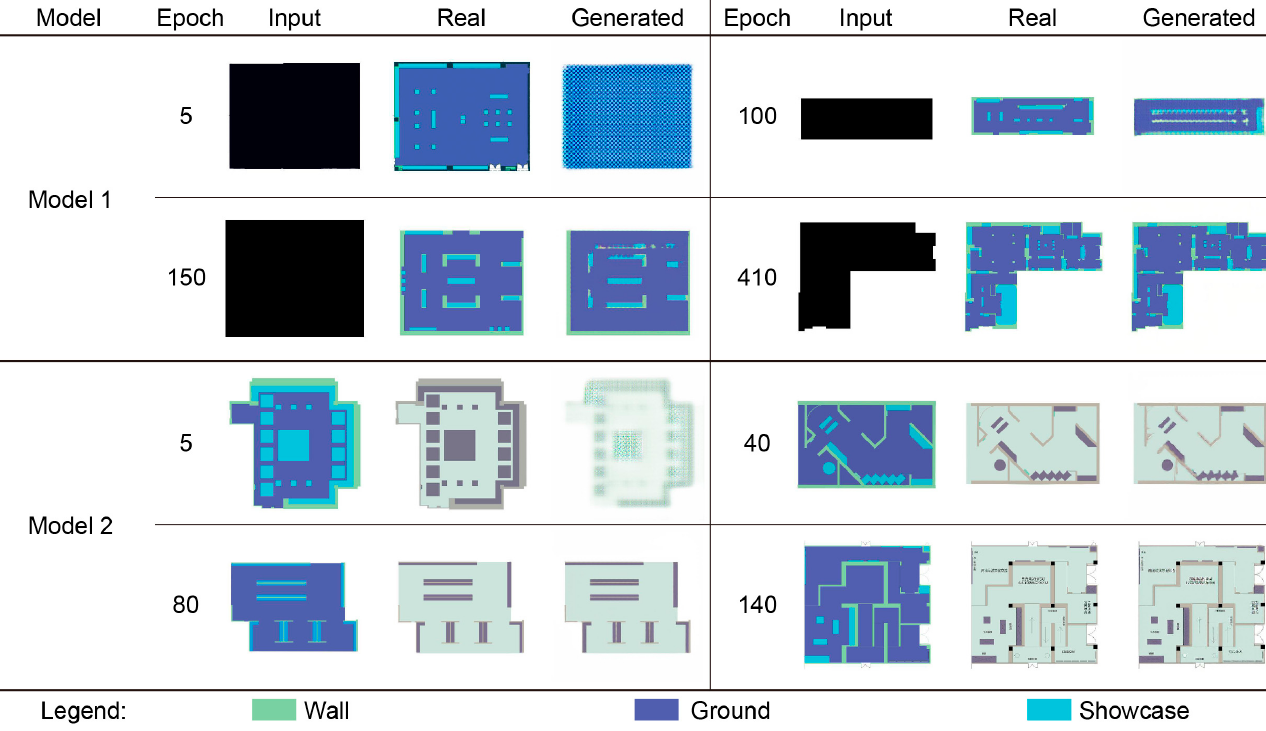
Figure 5. Model accuracy changes during iterative process (the Chinese annotations in the floor plan represent its spatial function).